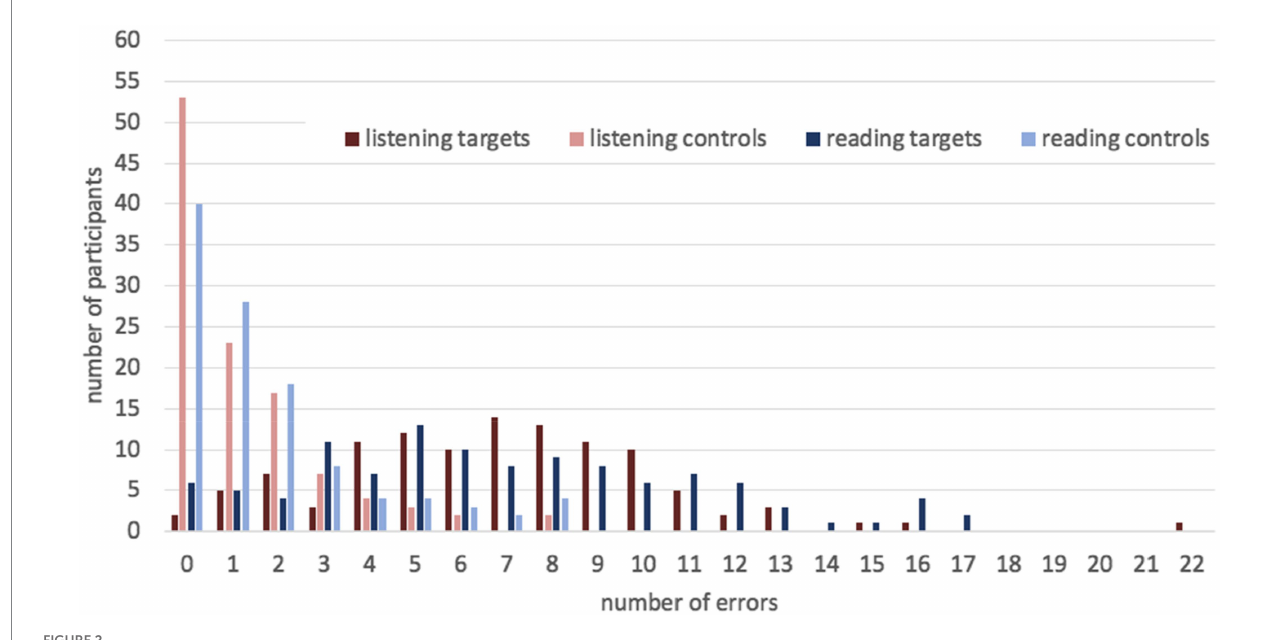
FIGURE 2 The number of errors per participant in target and control sentences in Experiment 2.